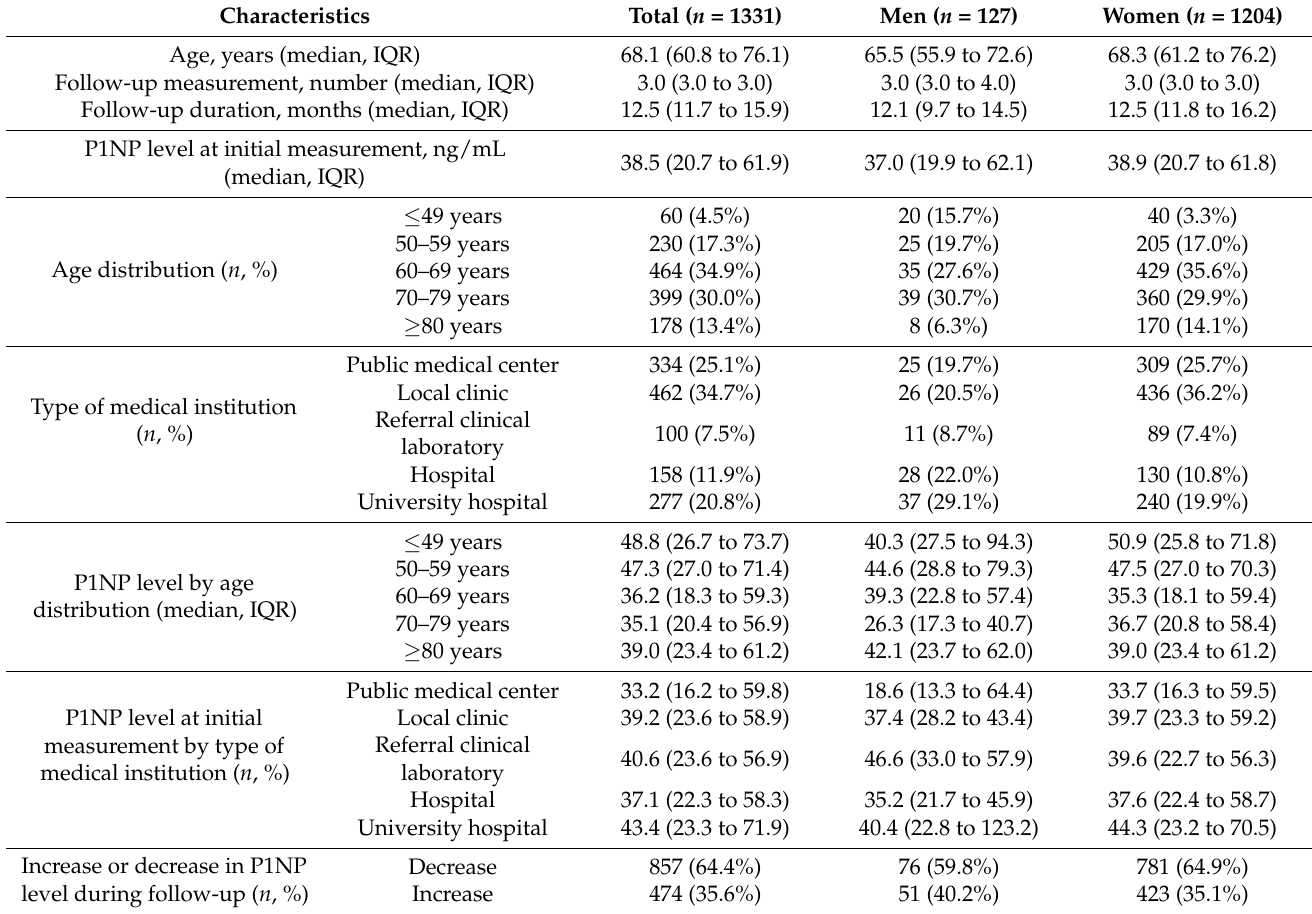
Table 1. Baseline characteristics of 1331 Korean